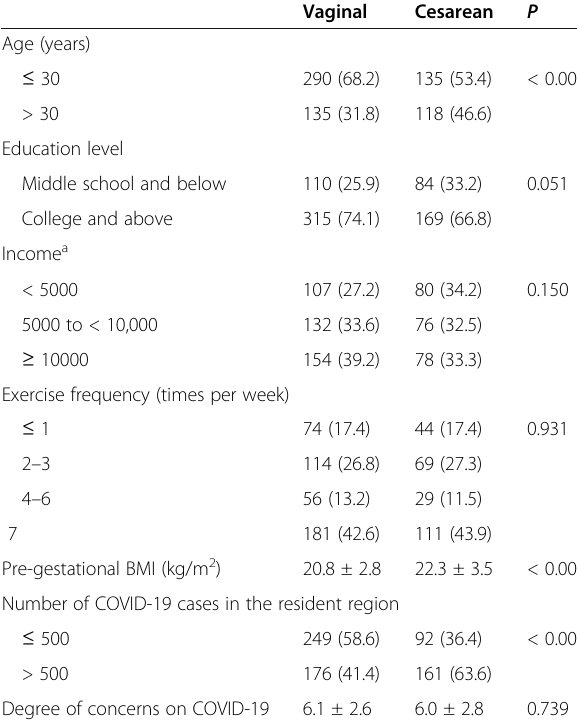
Table 1 General characteristics between participants with different delivery modes